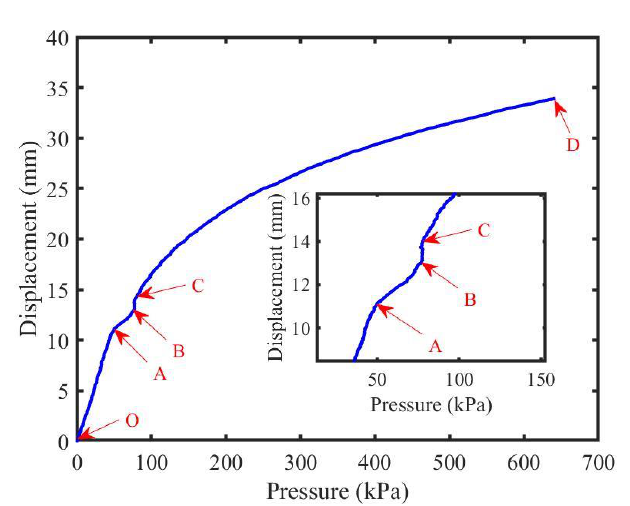
Figure 8. Pressure−displacement curve of tailings specimen with 15% moisture content under con- tinuous load. Points O, A, B, C, and D are the end points or critical points of the curve.